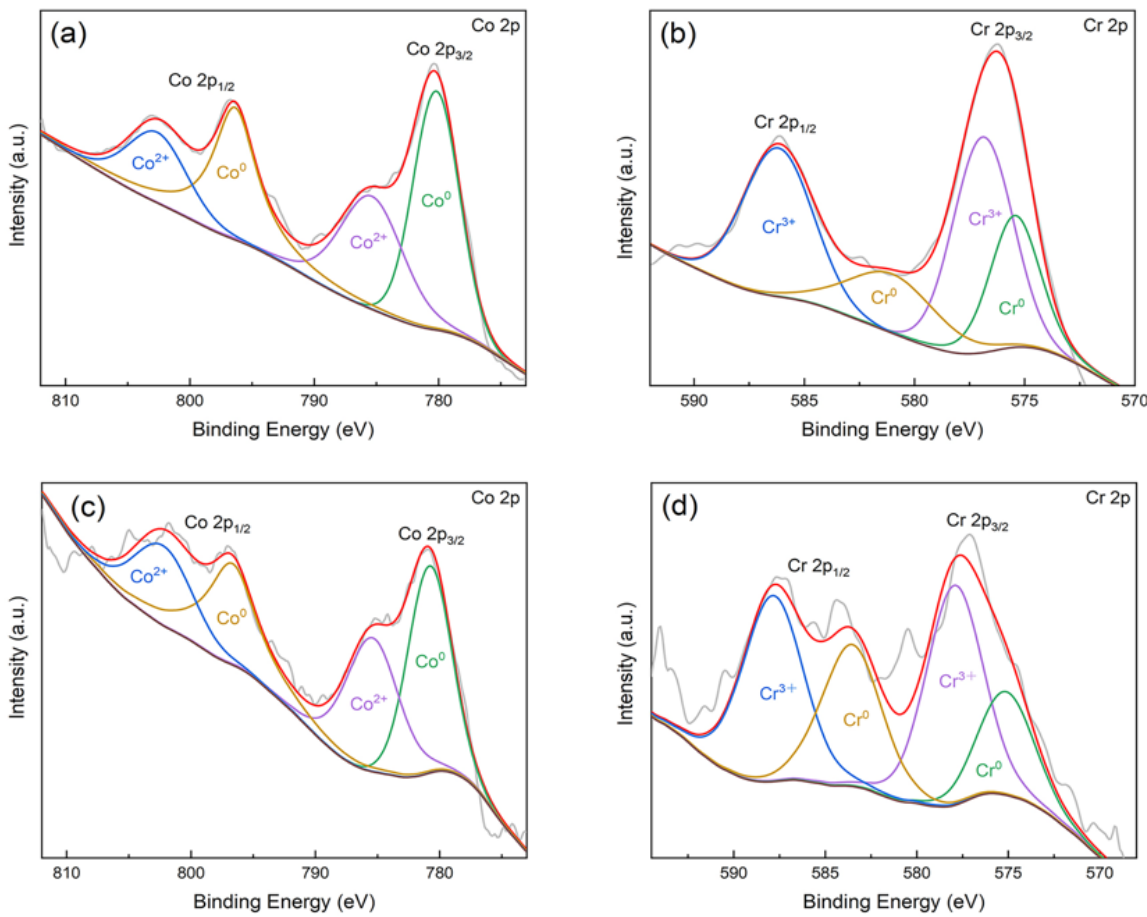
Figure 4. Fitting results of Co 2p and Cr 2p high-resolution spectra of the Co-Cr alloys: ( a ) Co 2p (CAST); ( b ) Cr 2p (CAST); ( c ) Co 2p (SLM); ( d ) Cr 2p (SLM).